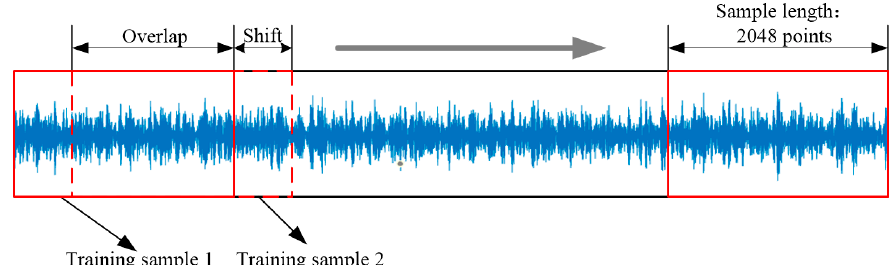
Figure 7. Data augmentation with overlap.